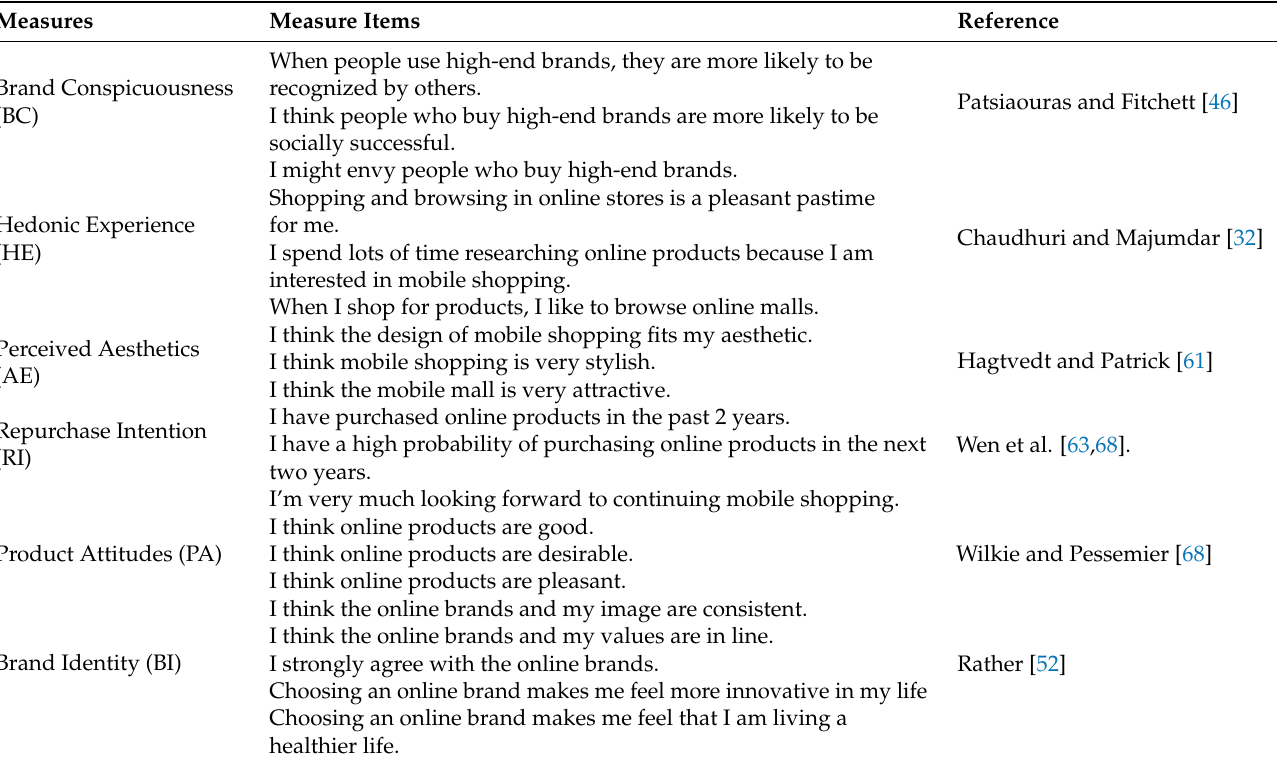
Table 2. Measurement items of the research.